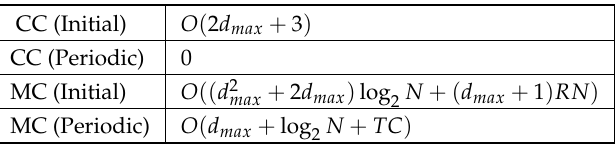
Table 1. Complexity analysis of the proposed